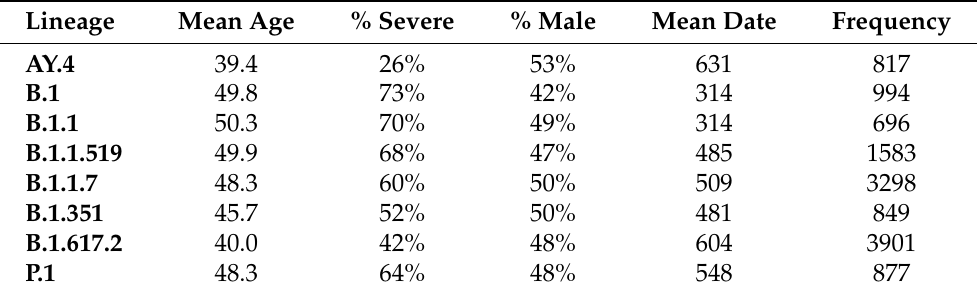
Table 2. Lineage-specific statistics of GISAID samples with metadata. Mean age, percentage of samples which are from patients with severe COVID-19 disease, percentage of samples from male populations, and the mean sample collection date of samples in the GISAID patient metadata validation data set from the lineages that appeared at least 400 times (i.e., frequency > 400). Mean sample collection date is defined in terms of days since 1 December 2019. The most recent lineages (highest sample date) trend to lower severity.